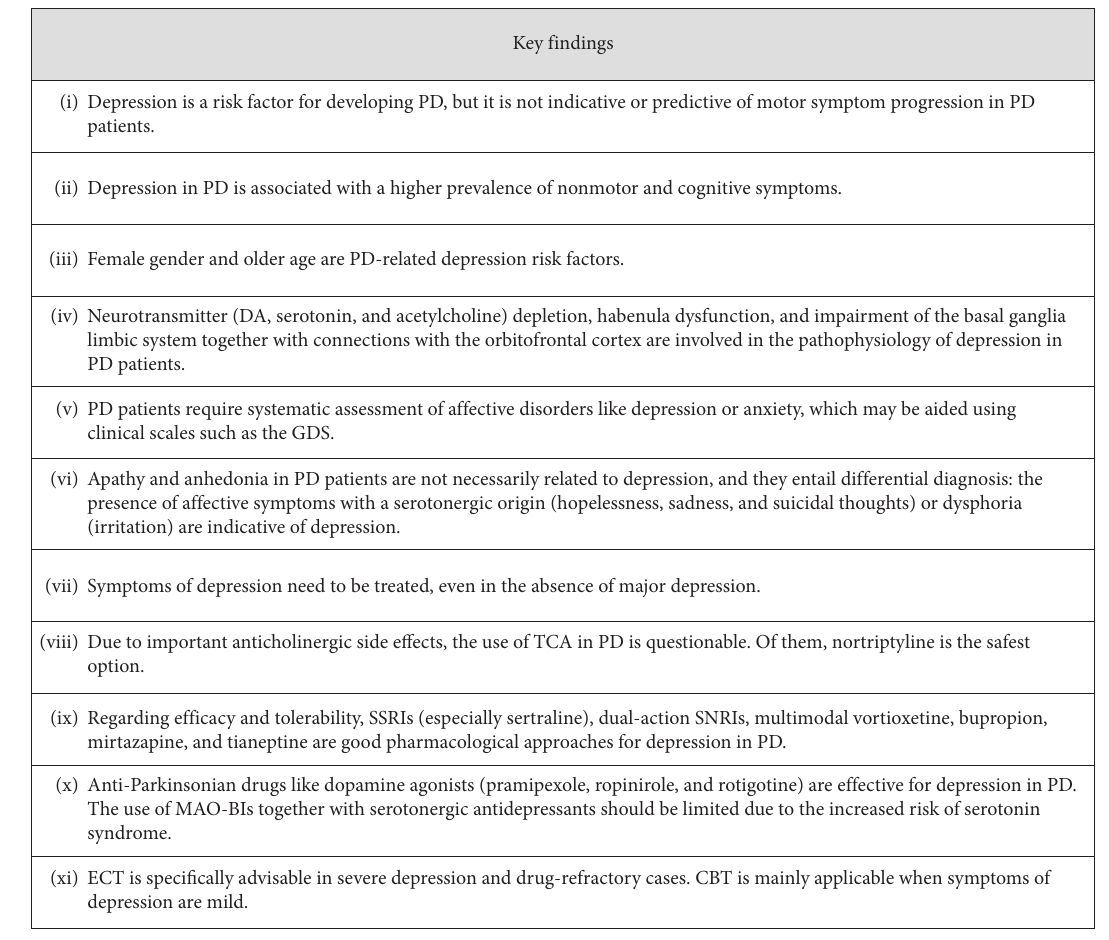
Figure 2: Highlights of the Delphi survey. PD, Parkinson’s disease; DA, dopamine; GDS, Geriatric Depression Scale; TCA, tricyclic antidepressants; SSRI, selective serotonin reuptake inhibitors; SNRIs, serotonin and norepinephrine reuptake inhibitors; MAO-BIs, type B monoamine oxidase inhibitors; ECT, electroconvulsive therapy; CBT, cognitive behavioural